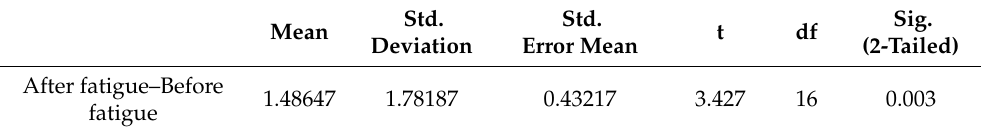
Table 11. Paired samples t -test results of electrodermal values.